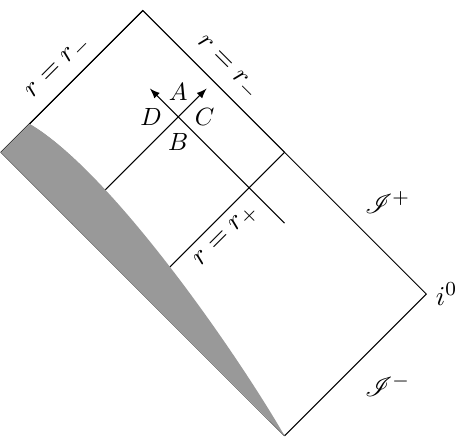
Figure 1 . Schematic Penrose diagram of a star collapsing to a regular black hole with concentric outgoing and ingoing null shells. The DTR relation is applied to the crossing point r 0 between outgoing and ingoing shells. The corresponding four spacetime regions A , B , C and D are depicted. We only depict the relevant quadrants of the maximally extended Penrose diagram of a regular black hole (see, e.g., [21] for the full